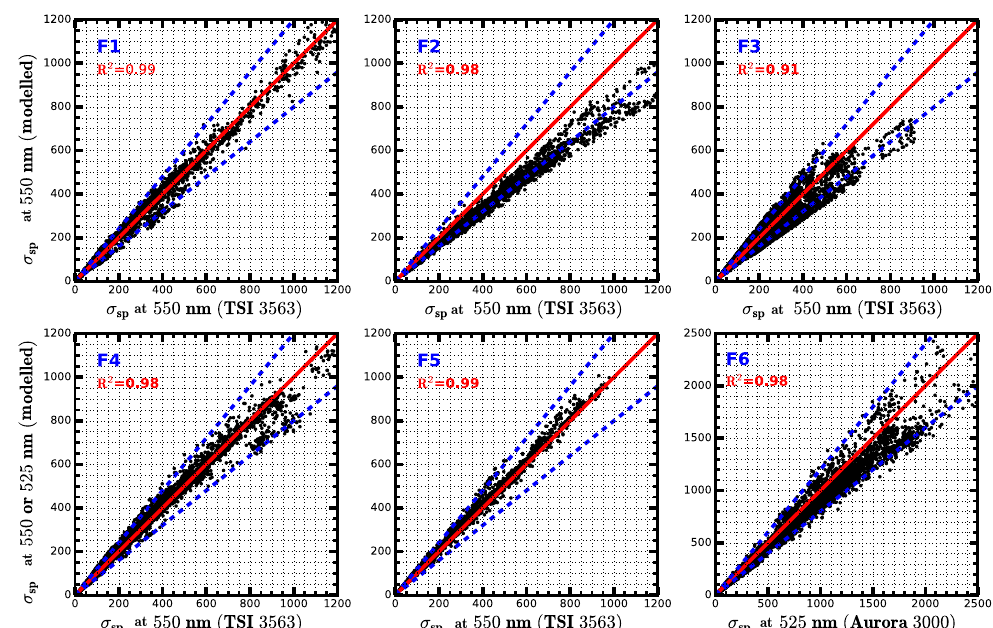
Figure 1. Comparisons between measured and calculated σ sp (Mm − 1 ), solid red lines are 1:1 references lines. Dashed blue lines are 20% relative difference lines. R 2 is square of correlation coefficient between measured and modelled σ sp . Blue text in the upper left corners corresponds to field campaigns as listed in Table